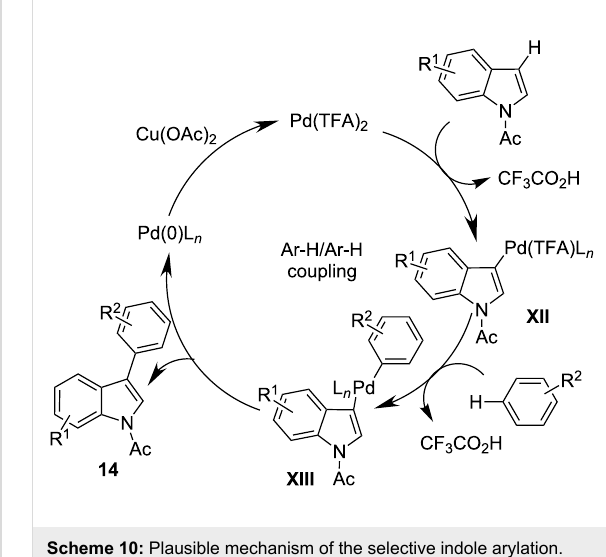
process. A high level of C-2 selectivity was achieved by using the N -pivalyl-substituted indole in the absence of